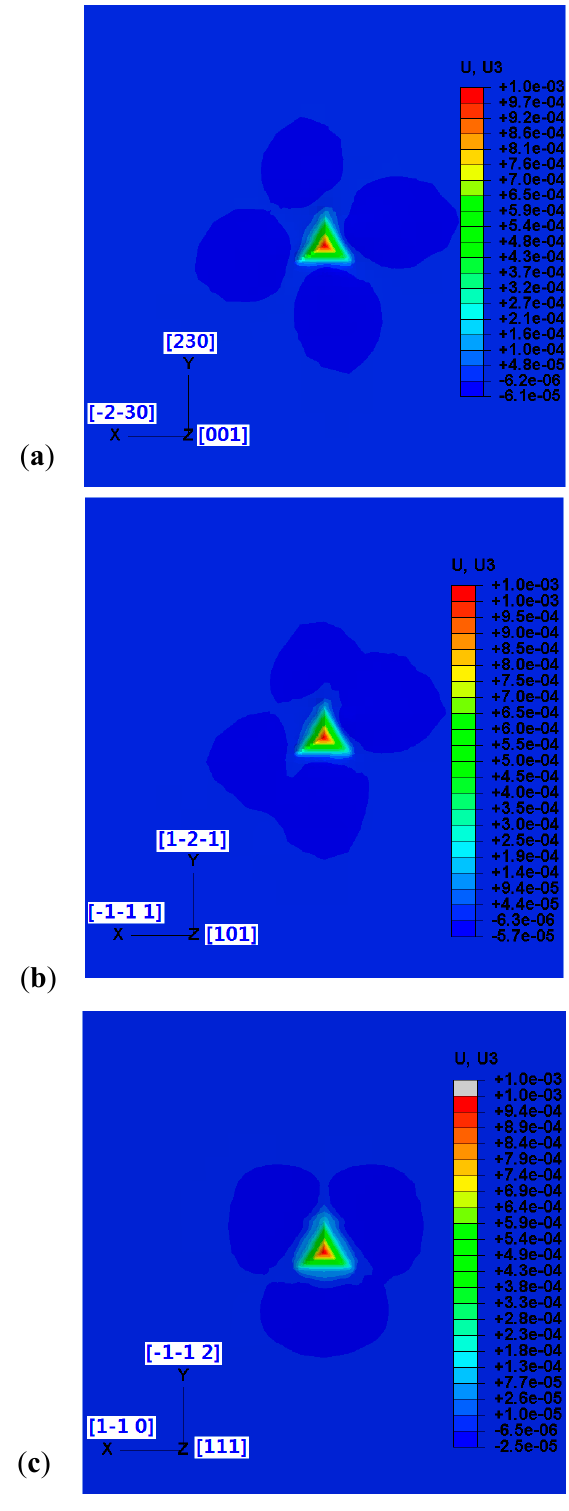
Figure 41. Simulated images of the indent impressions on a single-crystal Al workpiece with a Berkovich indenter (tip radius 200 nm) at different crystallographic orientations: ( a ) (001); ( b ) (101) and ( c ) (111) surfaces [136].